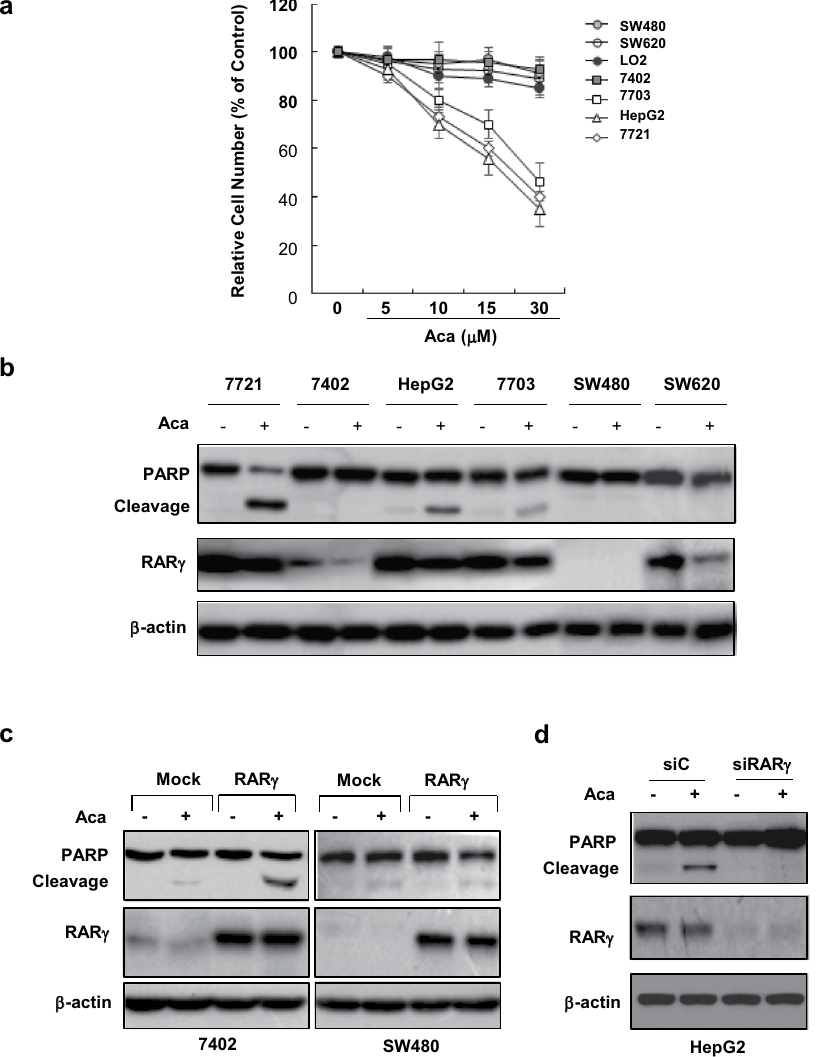
Figure 2. RAR γ mediates the anticancer effect of acacetin. ( a ) A number of cancer cell lines were treated with increasing concentrations of acacetin for 48 h and then subjected to MTT assays. The normal liver cell line LO2 was served as control. ( b ) The cancer cells were treated with 15 μ M acacetin for 24 h. The cell lysates were blotted for assaying the expression of RAR γ and PARP cleavage. β -actin was served as a loading control. ( c ) and ( d ) Bel- 7402 and SW480 cells were transfected with myc-RAR γ or empty vector (Mock) ( c ), while HepG2 cells were transfected with RAR γ siRNA (siRAR γ ) or control siRNA (siC) ( d ). Transfected cells were treated with 15 μ M acacetin or vehicle for 24 h. The expression of RAR γ and its association with PARP cleavage induced by acacetin were analyzed by Western blotting. β -actin was served as loading control. All blots were cropped to remove irrelevant or empty